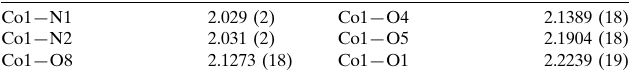
Selected bond lengths (A˚ ).